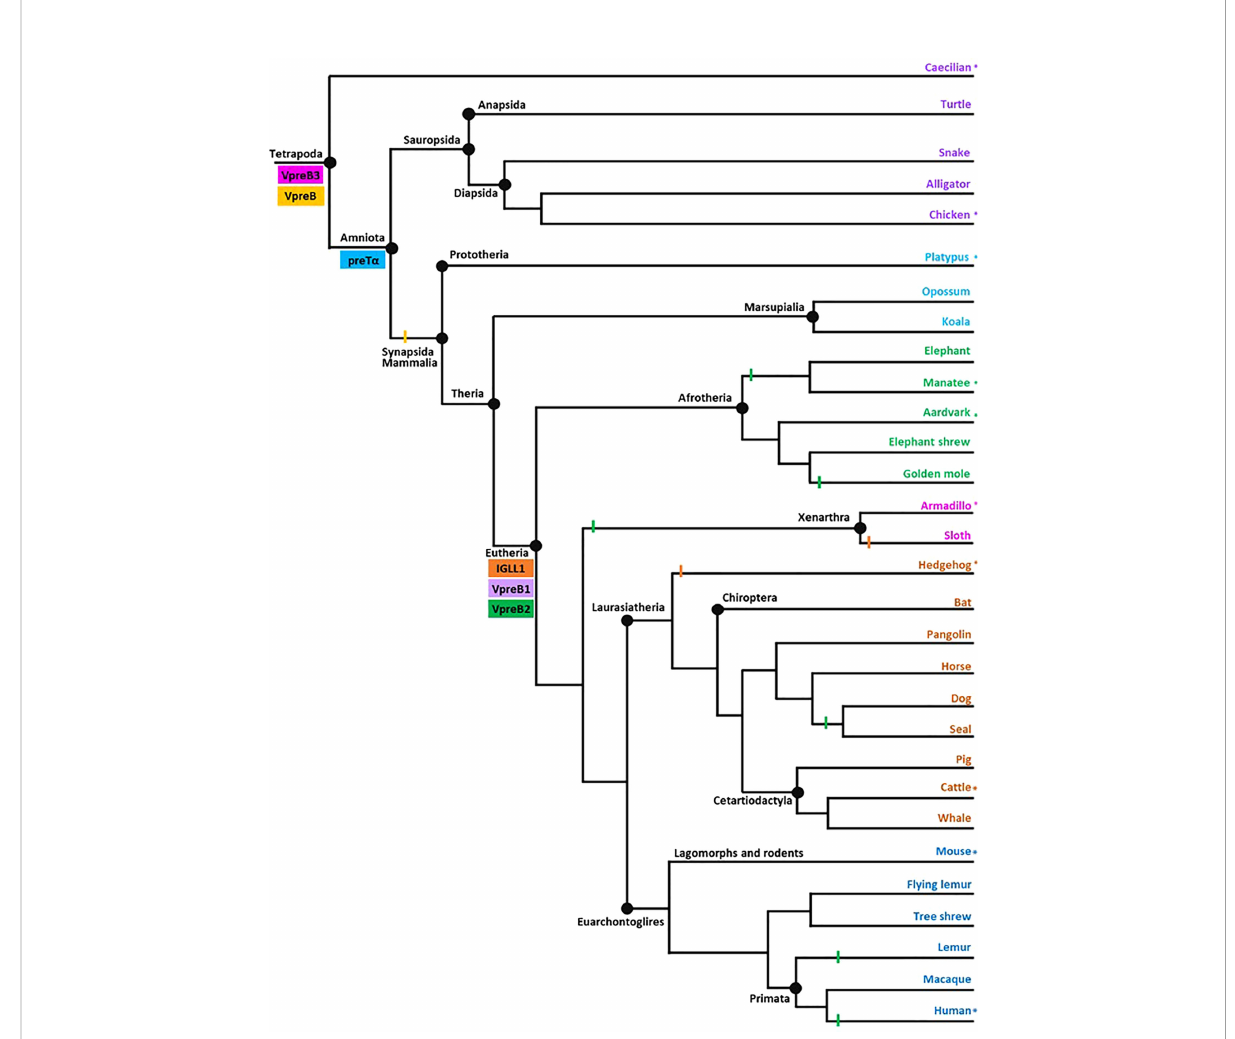
FIGURE 2 Model of surrogate light chain evolution in tetrapods. Cladogram of major tetrapod vertebrate groups illustrating the evolution of VpreB3, pre-T cell receptor alpha (PTCRA) chain, and genes used to construct surrogate light chain (VpreB1, VpreB2, and IGLL1). Multiple species inform each branch (see Supplementary Tables 1-3 for accession numbers, amino acid sequences, and genomic locations of genes for included species). Colored rectangles indicate gene emergence for the gene named within the box. Similarly colored lines represent gene loss or gene absence (e.g., solid line at Mammalia; due either to gene loss or genome fragmentation) within that branch. Tree topology is based on mammalian phylogeny reported in Murphy et al. (34); individual branches that expand on this published tree are informed by published phylogenies of that group (35 – 38). Evolutionary distances are not to scale. Asterisks (*) next to a branch name indicates a species for which we examined genomes for synteny. Branch name colors coordinate groups within the cladogram to those of sequence alignments and phylogenies (see Supplementary Figures 1-7). Created with